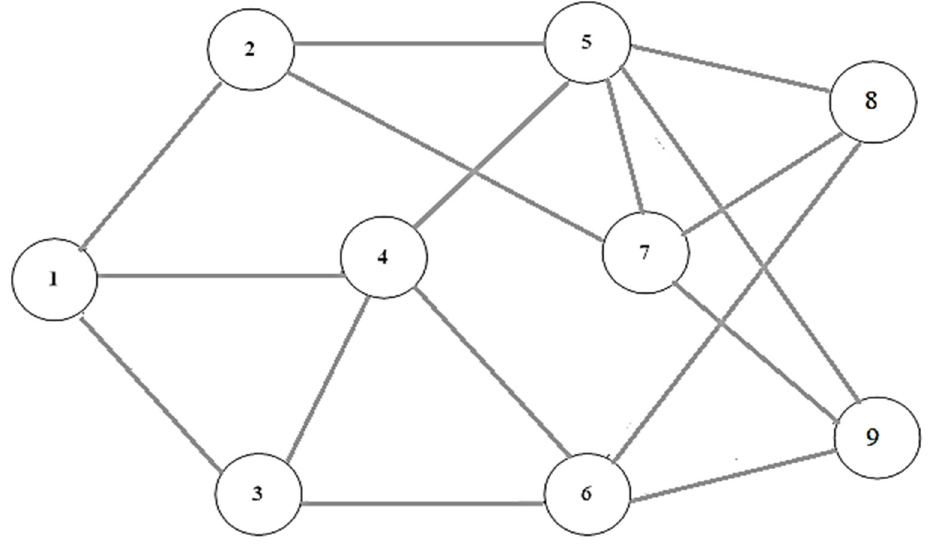
Figure 5. The main topology graph.